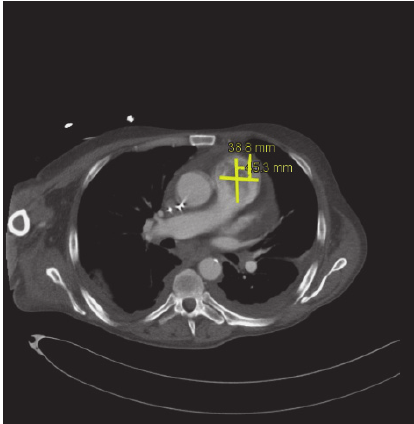
Figure 3: On the CT scan, the tumour is evaluated at 38.8 mm × 43.5 mm.